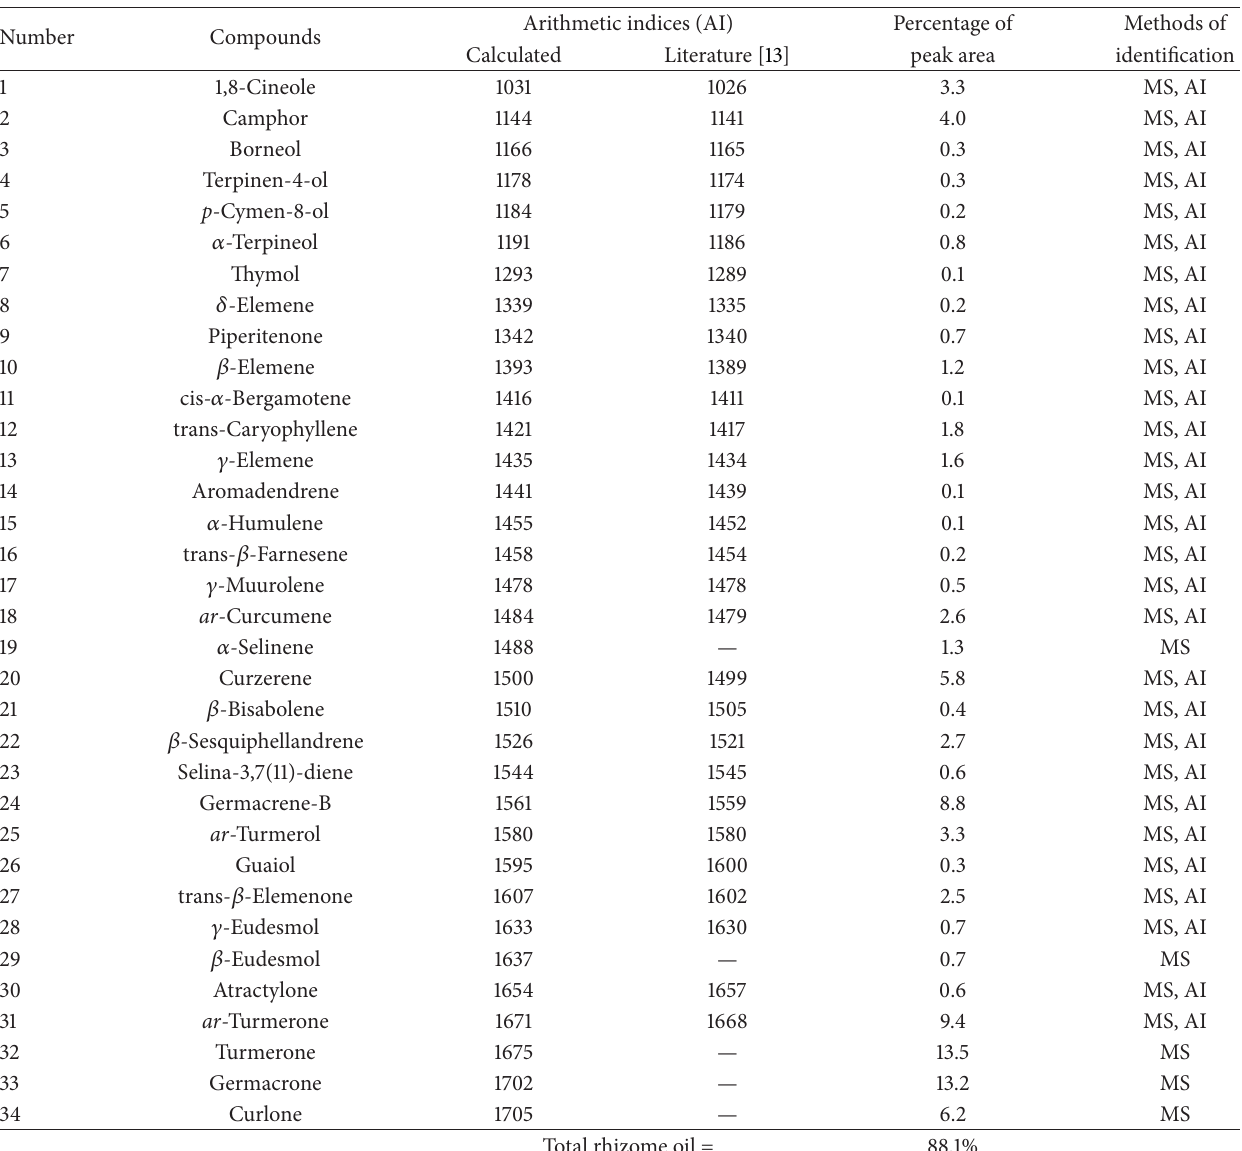
Table 1: Chemical composition of the essential oil of temu tis ’